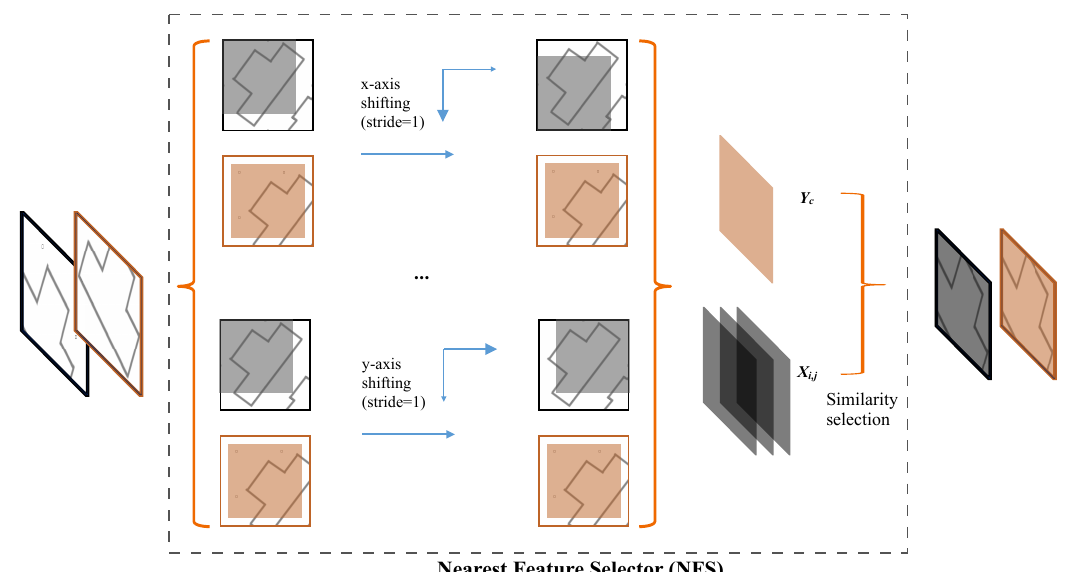
Figure 5. Overview of the nearest feature selector (NFS) module. The center area of ground truth slides over prediction along X- and Y-axes to generate overlaps that are used for similarity